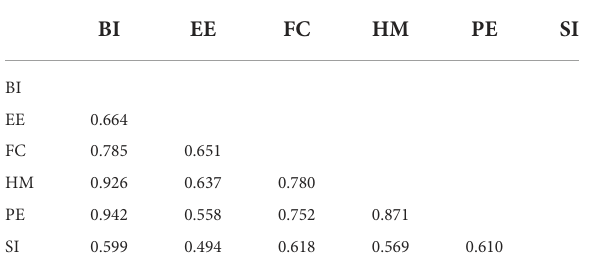
TABLE 7 Heterotrait-monotrait ratio (HTMT) values.